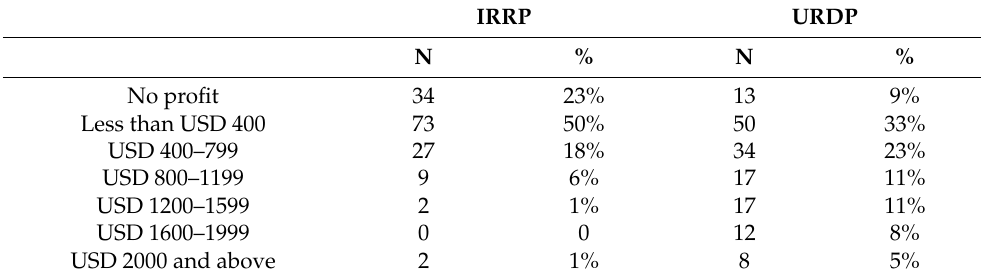
Table 2. Yearly income from farming before